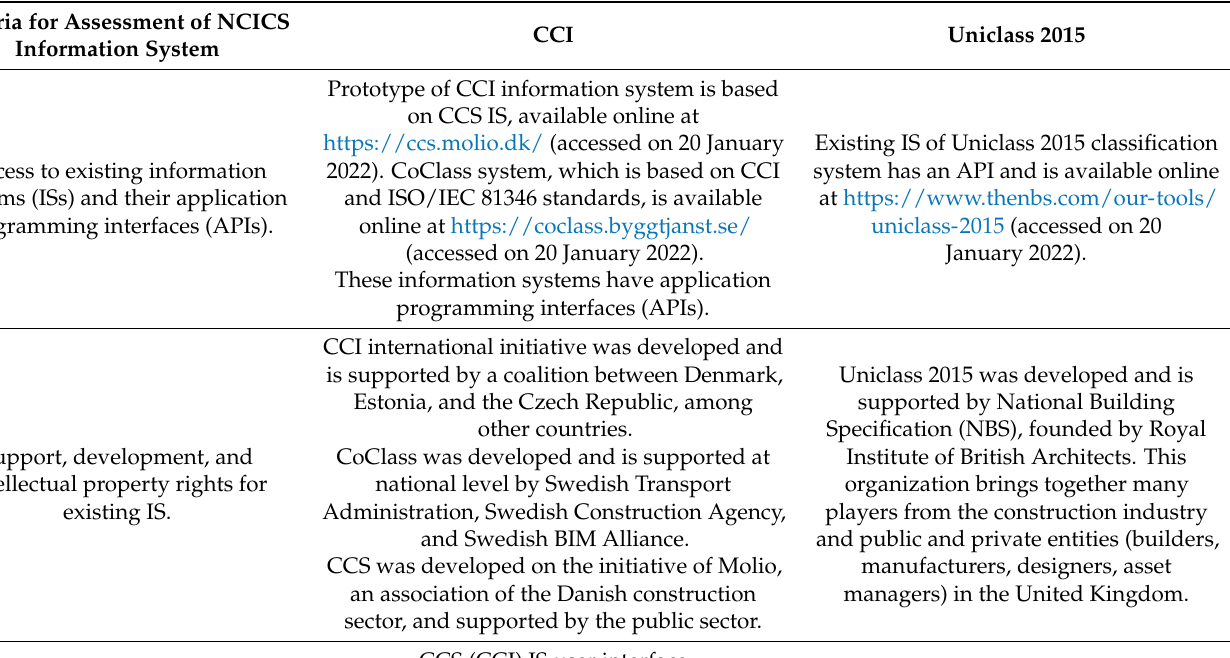
Table 4. NCICS alternative assessment model in terms of online